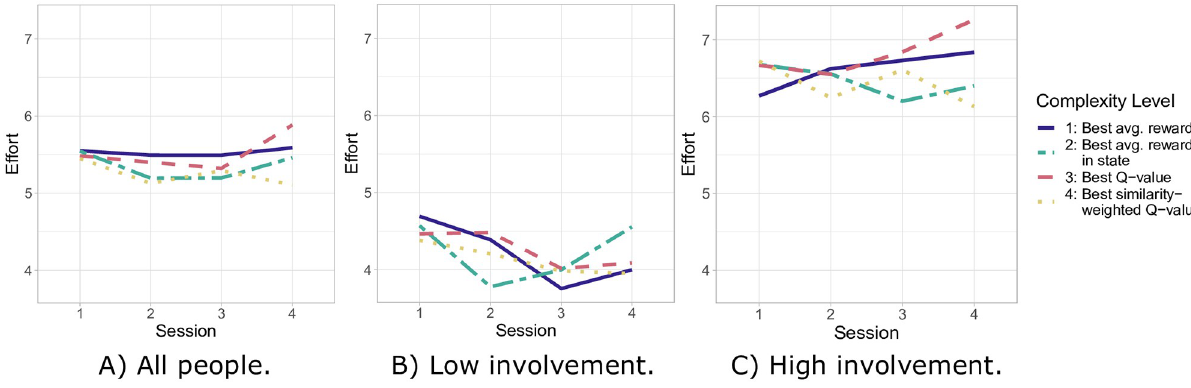
Fig 4. Mean effort per session and algorithm complexity